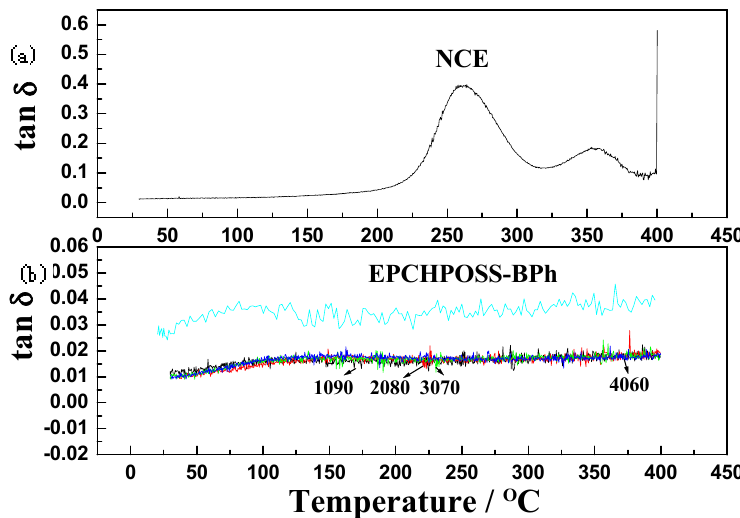
Figure 10. Damping factor (tan δ ) as a function of temperature for NCE, EPCHPOSS–BPh, 1090, 2080, 3070, 4060 polymers in the nitrogenous atmosphere: ( a ) NCE, ( b ) EPCHPOSS–BPh, 1090, 2080, 3070, and 4060.